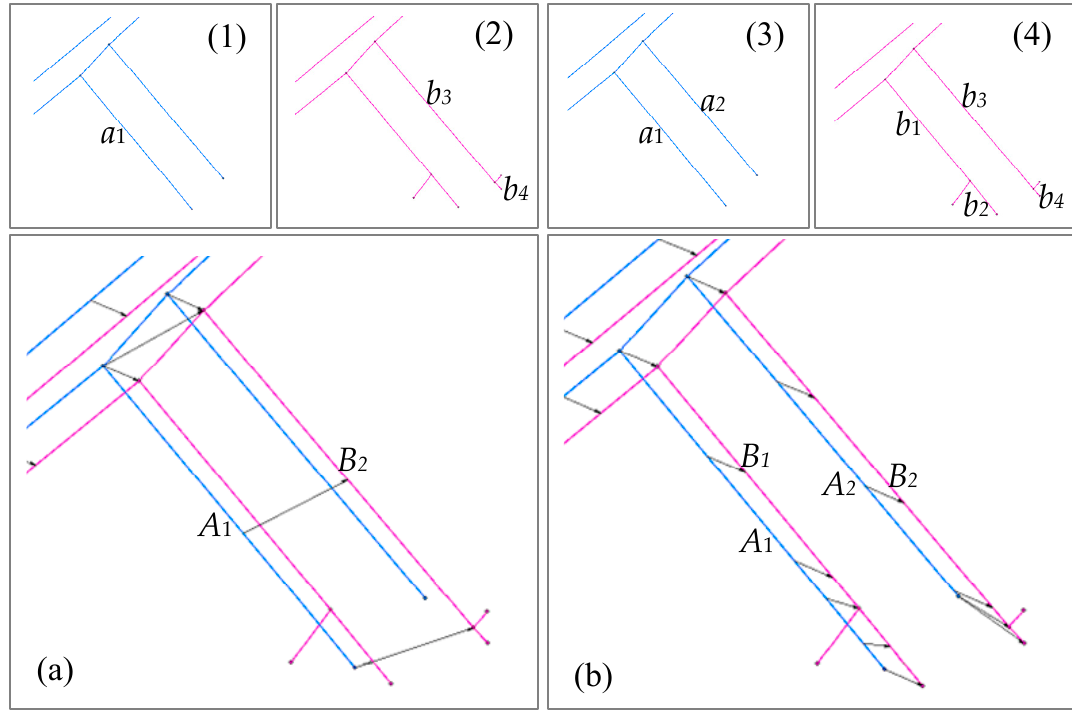
Figure 18. A case where the node–segment algorithm leads to an incorrect match, but the stroke algorithm leads to a correct match. The lines with arrowheads represent a matching relationship, ( 1 ) and ( 3 ) (blue lines) are integrated pipelines, and ( 2 ) and ( 4 ) (pink lines) are professional pipelines. ( a ) Shows the node–segment algorithm result; ( b ) shows the stroke algorithm result.